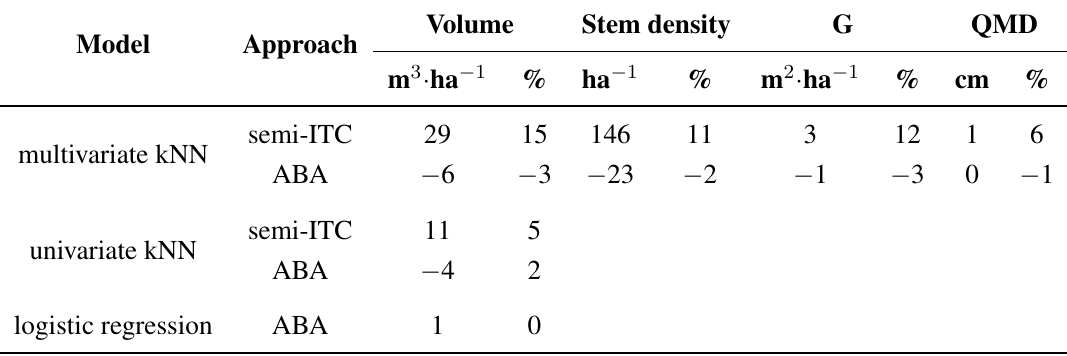
Table 3. Biases of the model predictions. G, basal area. QMD, quadratic mean diameter.